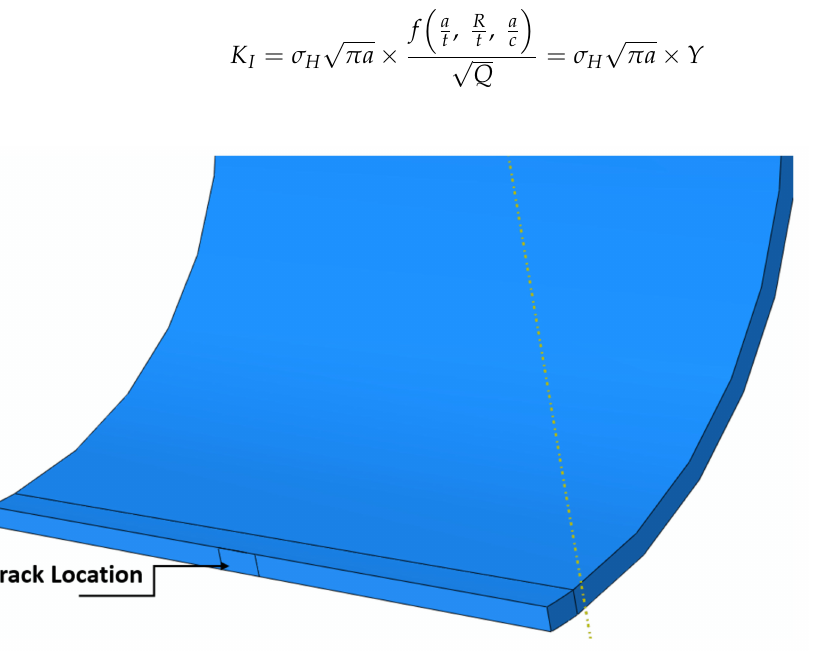
Figure 1. Crack location through the